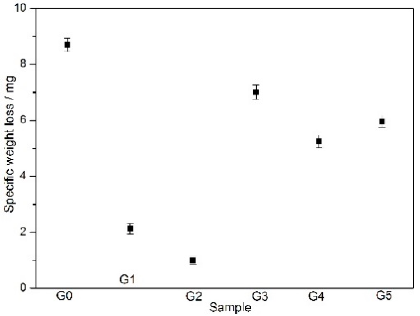
Figure 11. Corrosion weight loss of the coated samples after immersion in 3.5 wt.% NaCl solution.